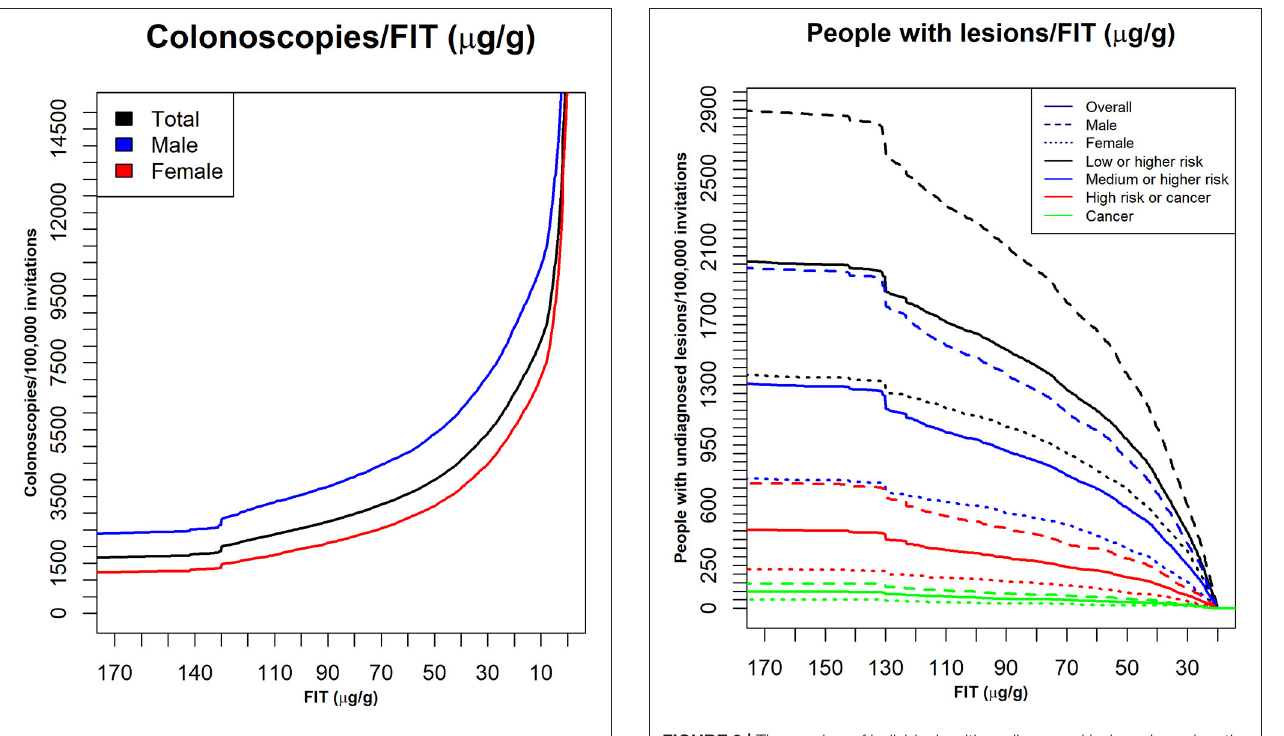
FIGURE 2 | The numbers of colonoscopies required with different FIT cut-off values. Data are shown for the whole population and for sex groups. X axis: FIT ( µ g hemoglobin/g feces); Y axis: number of patients with a positive test, per 100,000 invitations.